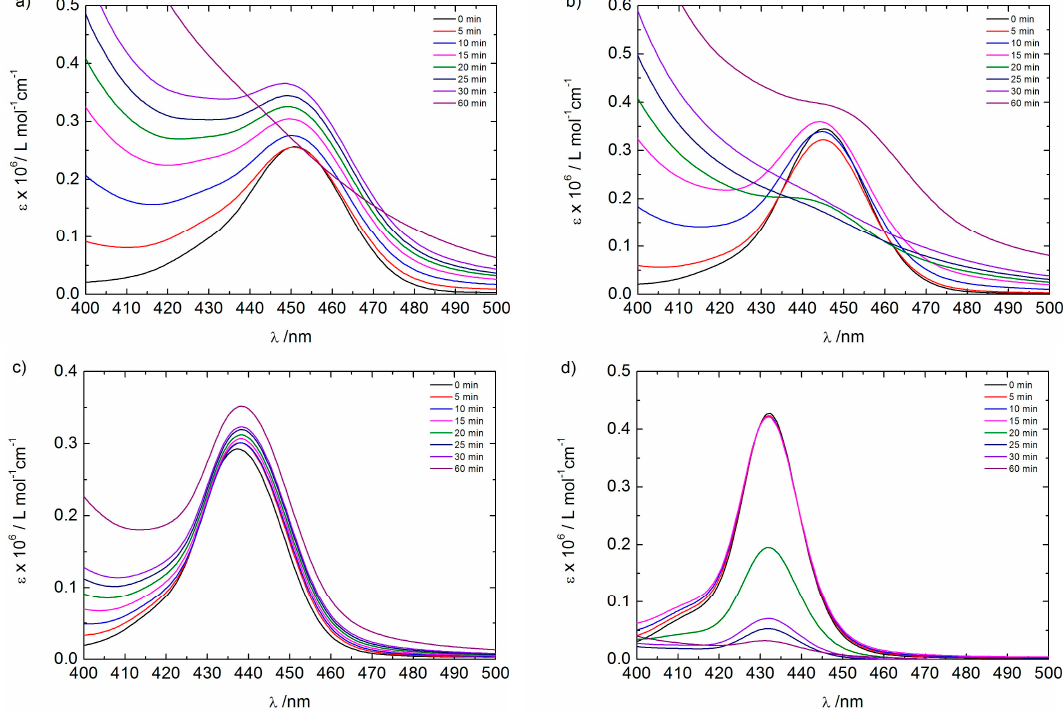
Figure 7. Change of the porphyrin Soret band during irradiation; ( a ) TMPyP diacid + PSS brush, l = 0.1; ( b ) TMPyP diacid; ( c ) TAPP diacid + PSS brush, l = 0.4; ( d ) TAPP diacid. Differences between the TMPyP and TAPP system can derive from their electronic structures.